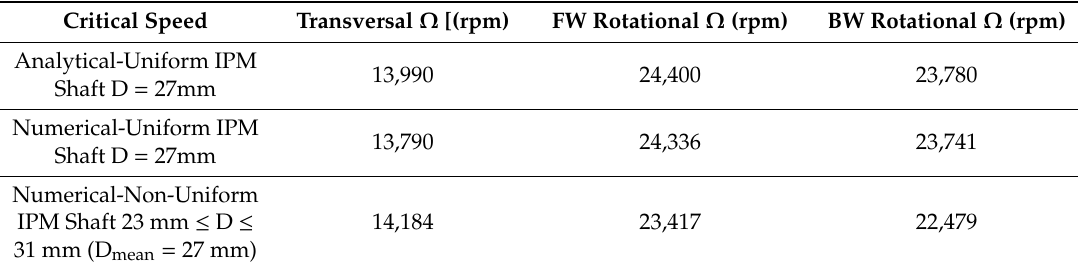
Table 5. Comparison of analytical and numerical results (IPM shaft with k 11 = k 22 = 10 6 N / m, L = 205.7 mm).